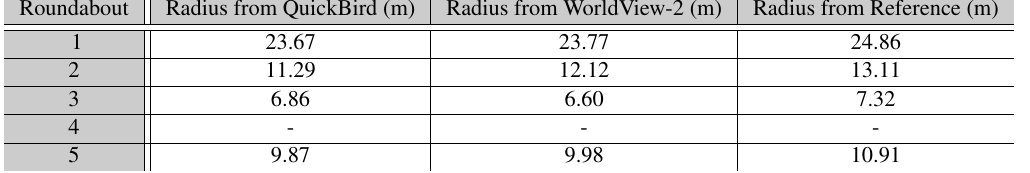
Table 2. The roundabout radii detected from the QuickBird, the WorldView- 2 and in the reference images.